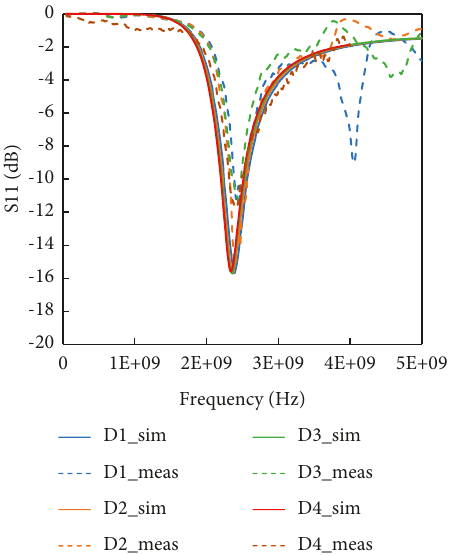
Figure 23: Simulation (solid lines) and measurement (dashed lines) results of S 11 parameters of D 1, D 2, D 3, and D 4.